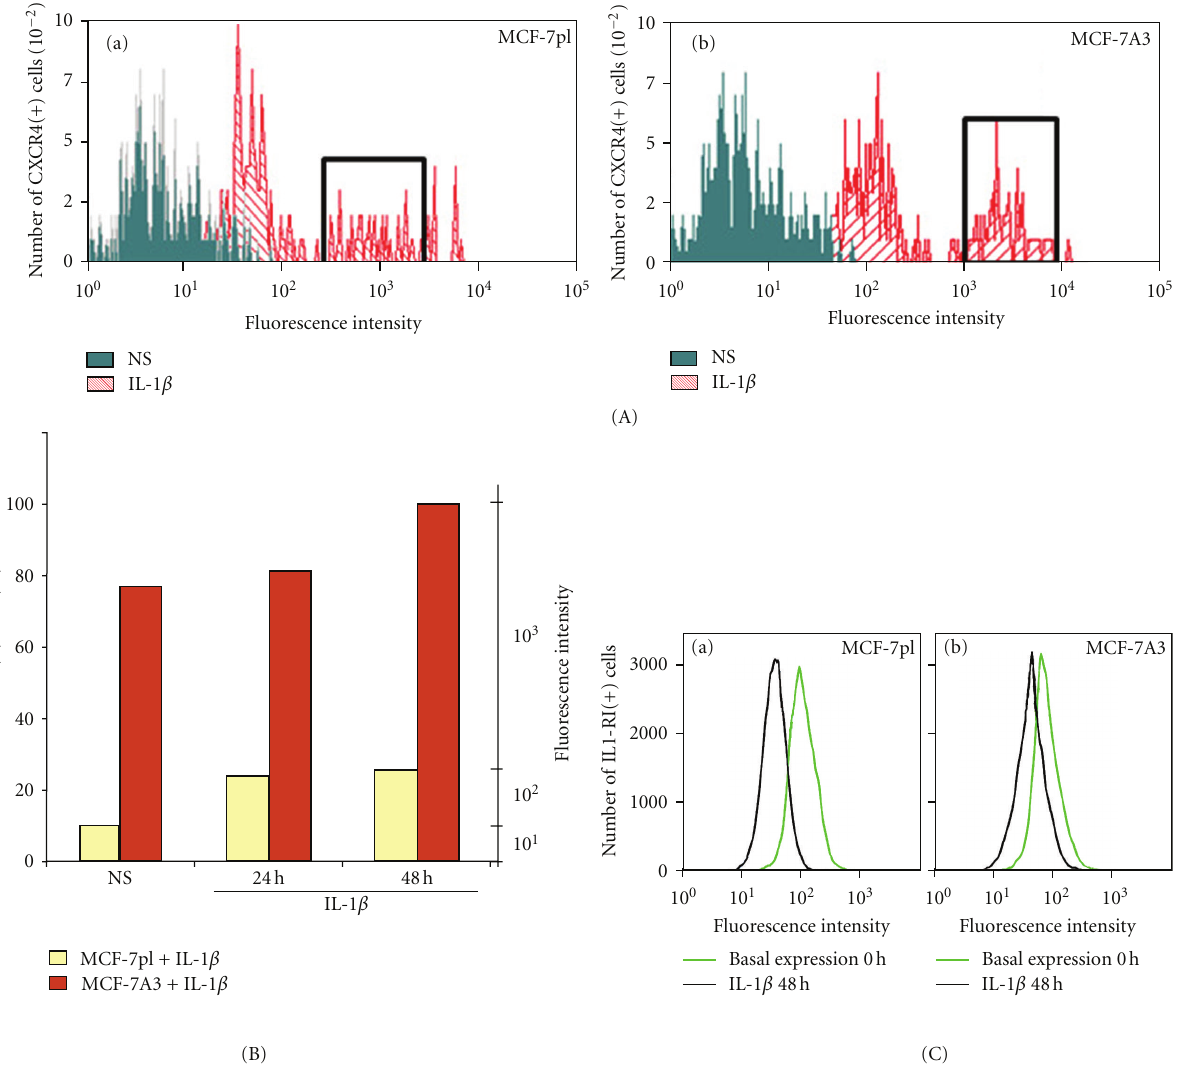
Figure 1: Isolation of subpopulation MCF-7A3 by selection of CXCR4 and IL1-RI expression. MCF-7 cells were starved for 18 h in culture media containing 0.1% FBS then stimulated with IL-1 β . After 48 h, cells were labeled with anti-CXCR4 antibody or with anti-IL1-RI antibody and analyzed by flow cytometry. (A) Higher expression of CXCR4 by cell subpopulations as selection marker. IL-1 β -stimulated cells were selected by three rounds of sorting. Boxes indicate the subpopulation that was isolated in the first and last rounds. (B) Percentage of cells expressing CXCR4 in MCF-7pl and MCF-7A3 cells nonstimulates and IL-1 β at 24 and 48h. (C) Expression of receptor IL1-RI in MCF-7pl and MCF-7A3 cells in basal conditions and under the stimulus of IL-1 β